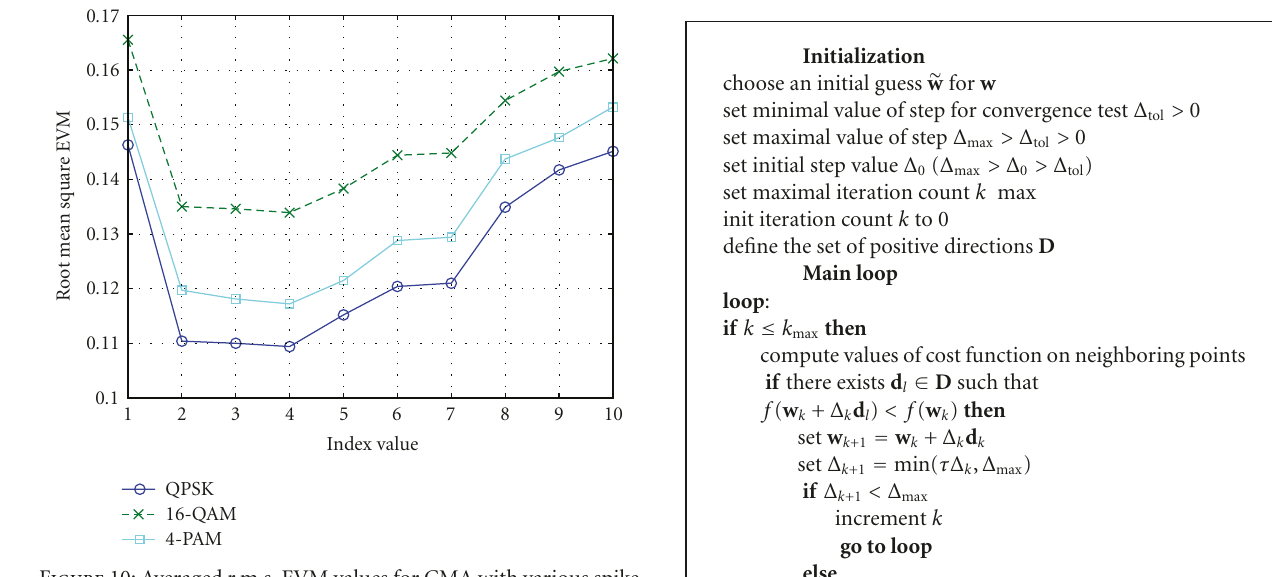
Figure 10: Averaged r.m.s. EVM values for CMA with various spike initializations.